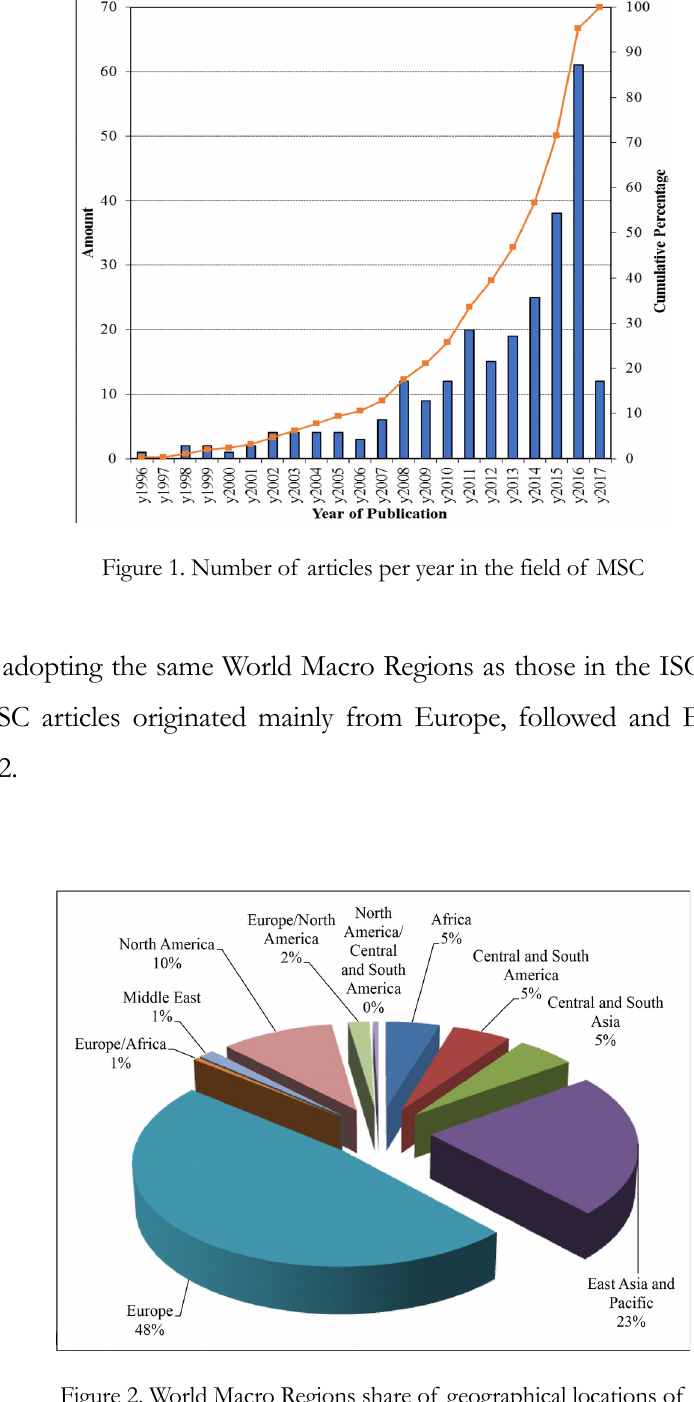
Figure 2. World Macro Regions share of geographical locations